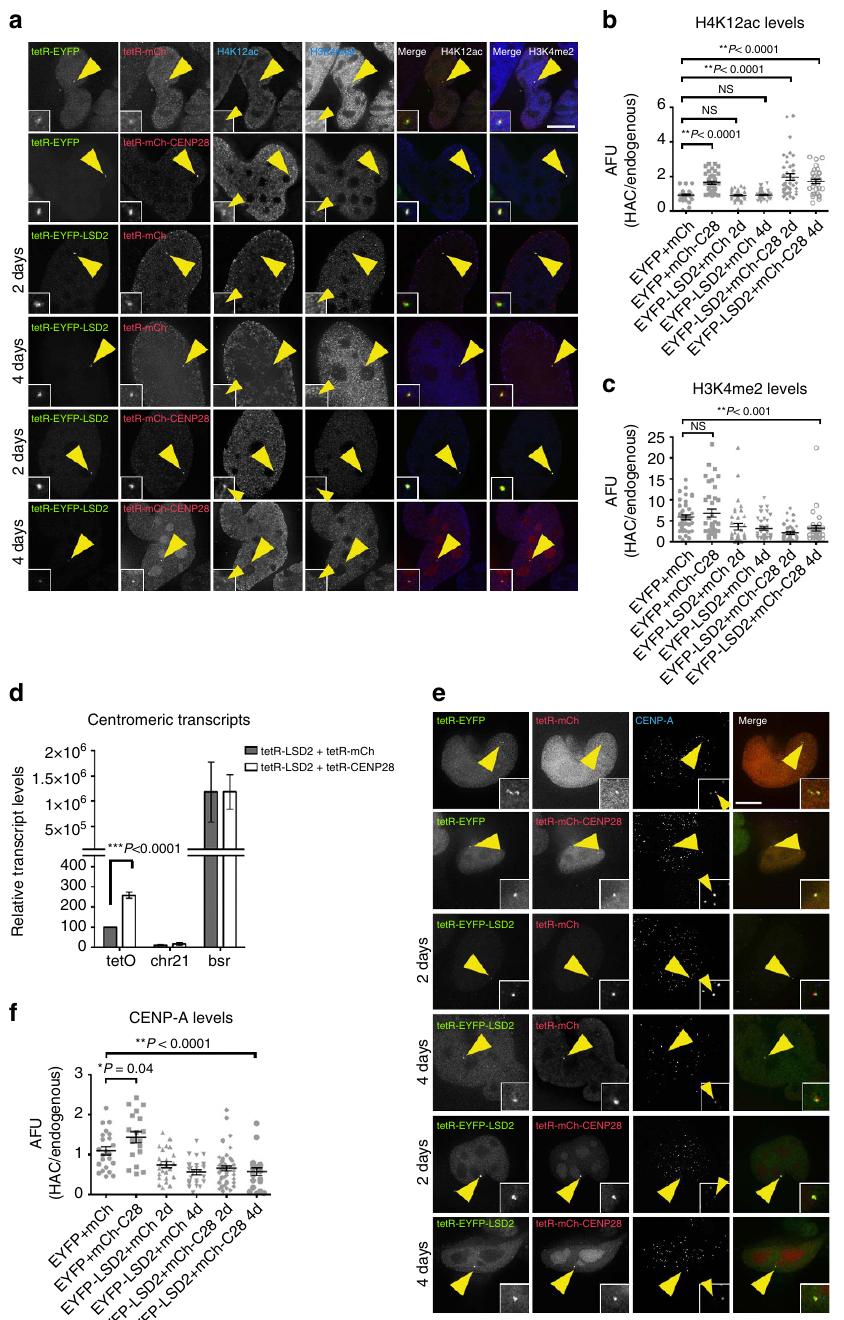
Figure 5 | Tethering a transcriptional activator to the alphoid tetO HAC centromere is not sufficient for kinetochore maintenance in the absence of H3K4me2. ( a ) Representative immunofluorescence images of 1C7 cells expressing the indicated tetR-fusion proteins at the indicated time points and staining for H4K12ac (panel 3) and H3K4me2 (panel 4). Merged images represent the overlay of EYFP and mCherry signals with H4K12ac (panel 5) or H3K4me2 (panel 6). Quantification of fluorescence signals of HAC-associated H4K12ac ( b ) and H3K4me2 ( c ) staining in individual cells transfected as in a . Solid bars indicate the medians and error bars represent the s.e.m. N ¼ two independent experiments per time point and staining. ( d ) RT-PCR analysis of the centromeric transcripts in 1C7 cells expressing tetR-EYFP-LSD2 WT together with either tetR-mCherry (grey bars) or tetR-mCherry-CENP-28 (white bars). tetO (alphoid tetO array), chr21 (centromere of chromosome 21) and bsr (Blasticidine resistance gene). Data represent the mean and s.e.m. of three independent experiments. ( e ) Representative immunofluorescence images of 1C7 cells expressing the indicated tetR-fusion proteins at the indicated time points and stained for CENP-A. ( f ) Quantification of HAC-associated CENP-A signals in individual cells transfected with the indicated tetR- fusion constructs. The values of the HAC-associated CENP-A signals were normalized for the mean of the CENP-A signals of endogenous centromeres. Solid bars indicate the medians and error bars represent the s.e.m. N ¼ two independent experiments per time point and staining. Asterisks indicate significant differences (* P o 0.05; ** P o 0.01; Mann–Whitney’s test). Scale bars, 10 m m.